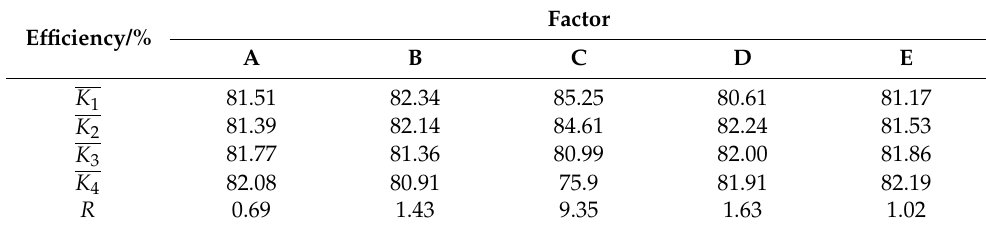
Table 6. Range analysis for pump efficiency.